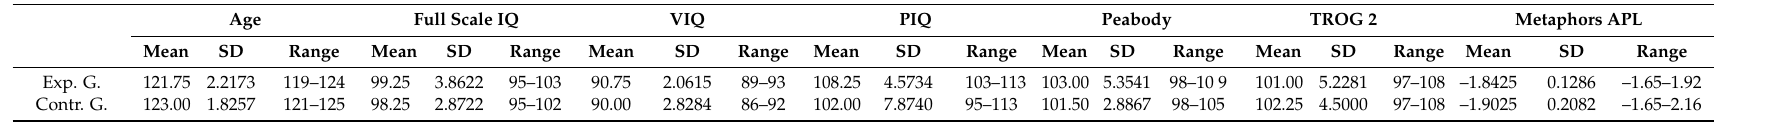
Table 1. Descriptive statistics for IQ scores (Full scale, Verbal, Performance). Peabody, TROG 2, APL., in the experimental and control groups (mean, standard deviation,